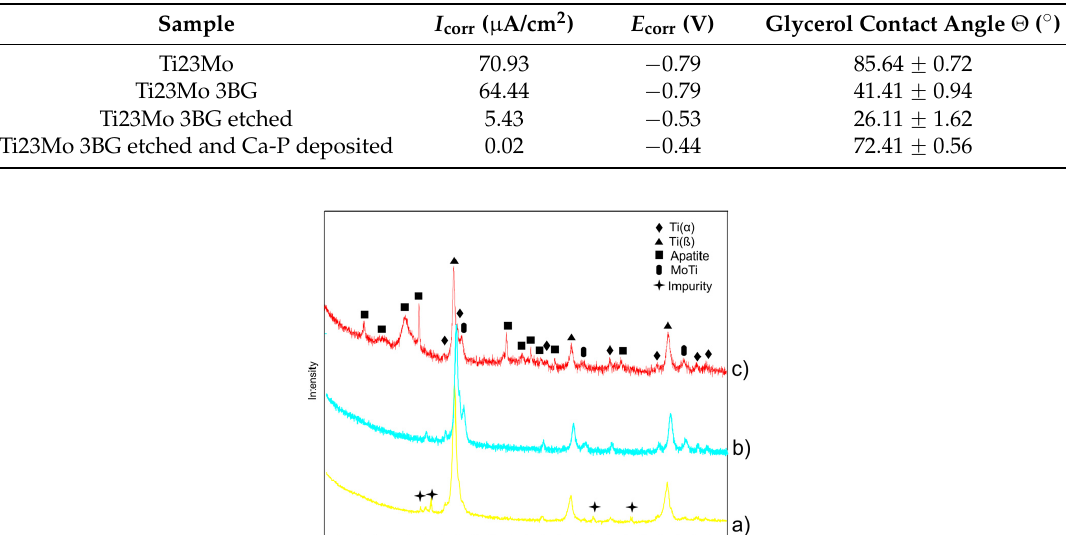
Table 2. Corrosion current density I corr , corrosion potential E corr and glycerol contact angles Θ of the nanocrystalline Ti23Mo and Ti23Mo 3BG nanocomposites before and after electrochemical etching as well as after additional Ca-P deposition.